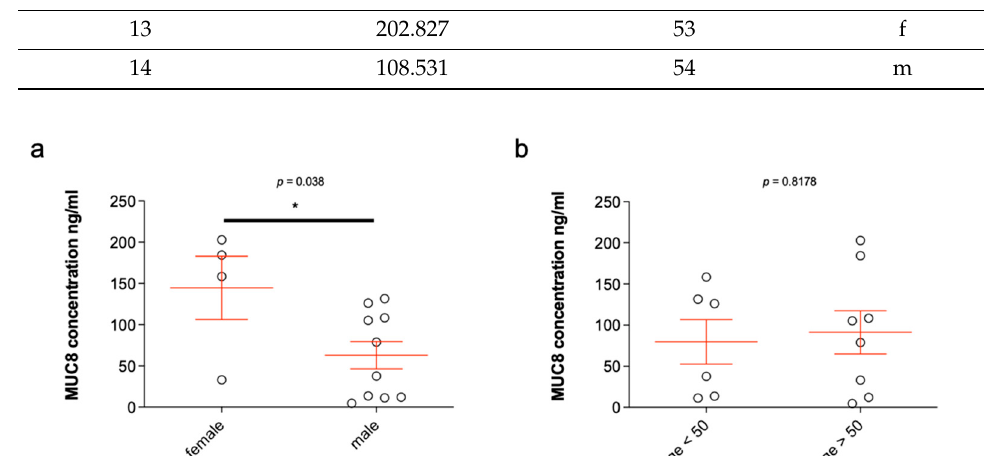
Figure 4. MUC8 concentrations in salivary stones from the excretory ducts of the submandibular glands in relation to sex ( a ) and age ( b ). The concentrations of MUC8 are shown in ng/mL for each single stone analyzed ( n = 14, Table 1). The MUC8 concentrations shown in the bar chart ( a ) illustrate the large scatter of concentration values between stones (Table 1). Statistically, the MUC8 concentrations determined are significantly higher in female patients ( a ; p ≤ 0.038). When considering MUC8 values in over and under 50-year-old patients, no significant difference can be detected ( b ; p ≤ 0.8178) (* p ≤ 0.05).